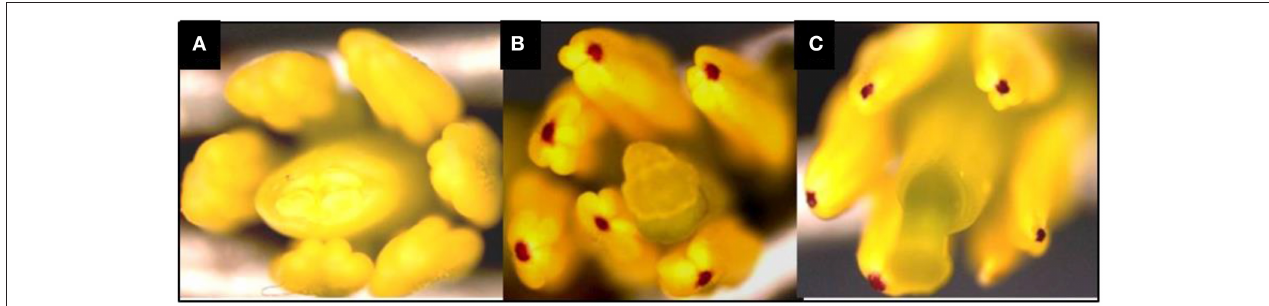
FIGURE 2 | Anthocynin pigmentation on anther tip, a dominant morphological marker used in inter-specific hybridity testing. (A) Pigmentation absent in B. oleracea botrytis group “Pusa Sharad.” (B) Pigmentation present in B. carinata “NPC-9.” (C) Present in F 1 ’s of Pusa Sharad × NPC-9.